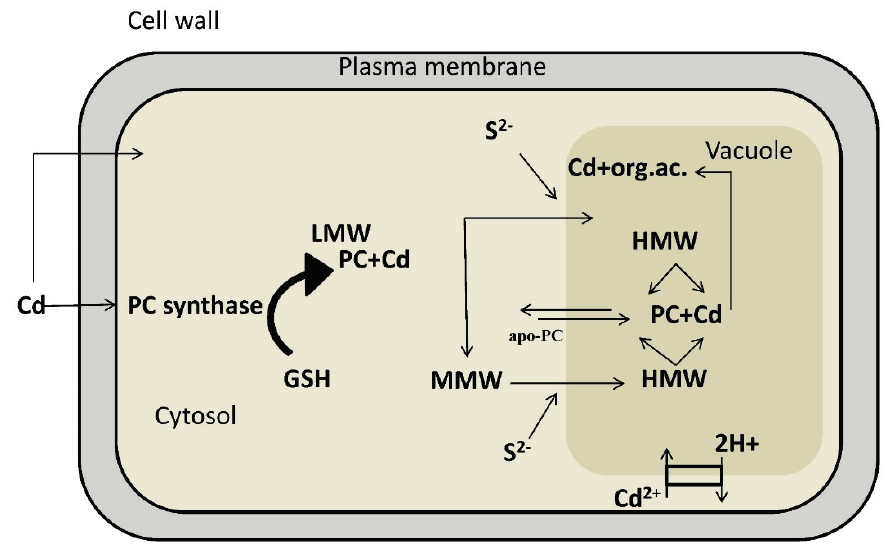
Figure 1. Diagram illustrating the mechanisms involved in cadmium chelation